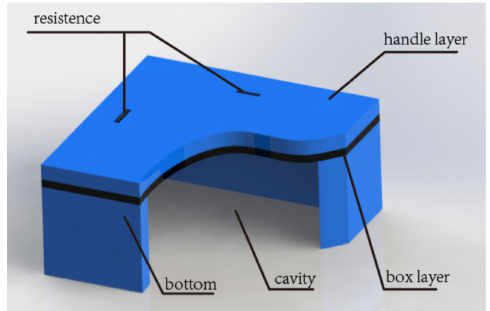
Figure 2. Diagram of the piezoresistive pressure sensor with back cavity. The thickness of the device layer is the sum of the thickness of the handle layer and the thickness of the box